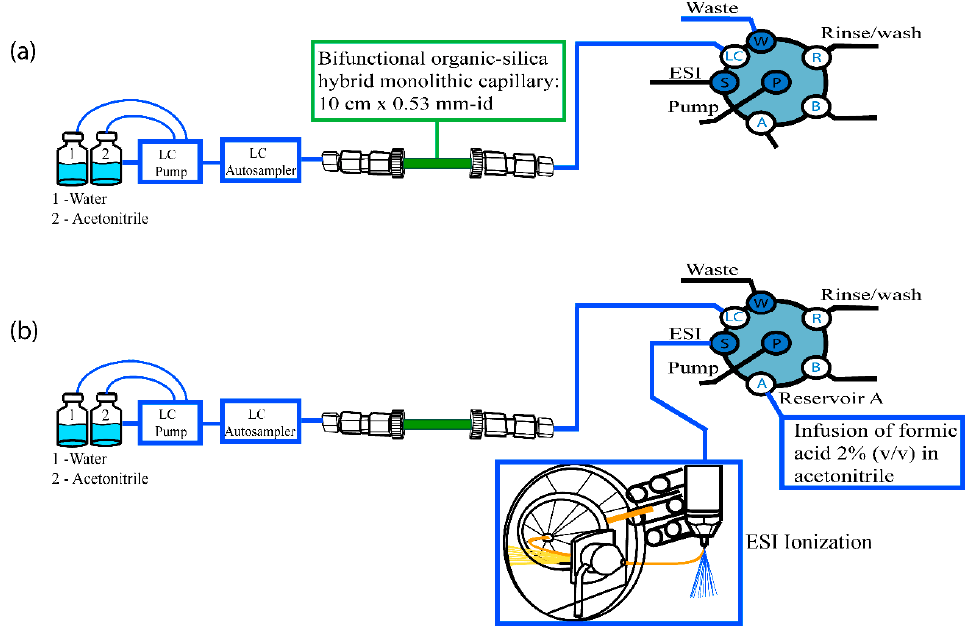
Figure 4. Instrumental configuration of in-tube SPME-MS/MS. ( a ) Sample extraction on monolithic capillary column, ( b ) Elution of the analytes by switching the valve position. Adopted from [137] with permissions.